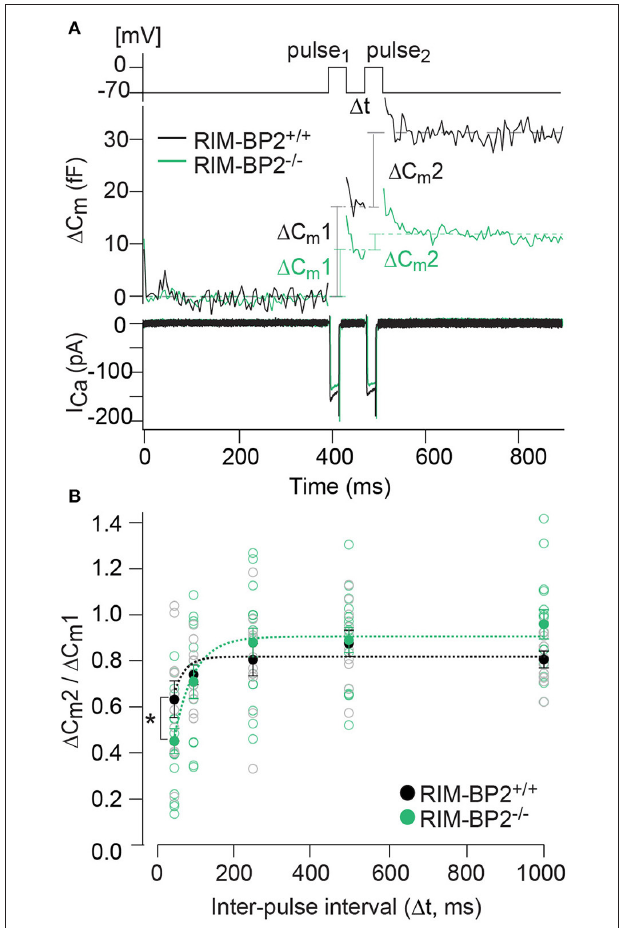
FIGURE 8 | RIM-BP2 facilitates fast recruitment of SVs after RRP-depletion. (A) A paired-pulse protocol was used to measure SV replenishment after RRP-depletion. Average exocytic membrane capacitance traces ( C m , middle) and corresponding Ca 2 + -currents (I Ca , bottom) of RIM-BP2 − / − ( n = 18, green) and control ( RIM-BP2 + / + , n = 14, black) IHCs in response to a pair of 20ms depolarizations separated by an inter-pulse interval ( 1 t) of 50ms (top). SV replenishment was measured as the paired-pulse ratio between the second and the first exocytic membrane capacitance changes ( 1 C m 2/ 1 C m 1). (B) Paired-pulse ratios ( 1 C m 2/ 1 C m 1) at varying inter-pulse intervals ( 1 t) of RIM-BP2-deficient ( RIM-BP2 − / − , n = 18, green) and control ( RIM-BP2 + / + , n = 14, black) IHCs were significantly reduced in RIM-BP2 − / − IHCs for RRP recovery times of 50ms ( p = 0.02). For longer RRP recovery times ( > 50ms) RRP replenishment seemed normal in RIM-BP2-deficient IHCs ( p = 0.1–0.8). The time course of RRP recovery was estimated by fitting the paired-pulse data with a single exponential fit function (dashed lines). τ was significantly slower in RIM-BP2 − / − IHCs ( RIM-BP2 − / − , n = 5, green) compared to control ( RIM-BP2 + / + , n = 5, black) IHCs ( p = 0.04). Data represent IHC averages (empty circles) and IHC grand averages, mean ± SEM (filled circles); Student’s t- test: * p < 0.05. (A,B) n = number of IHCs; age of mice: